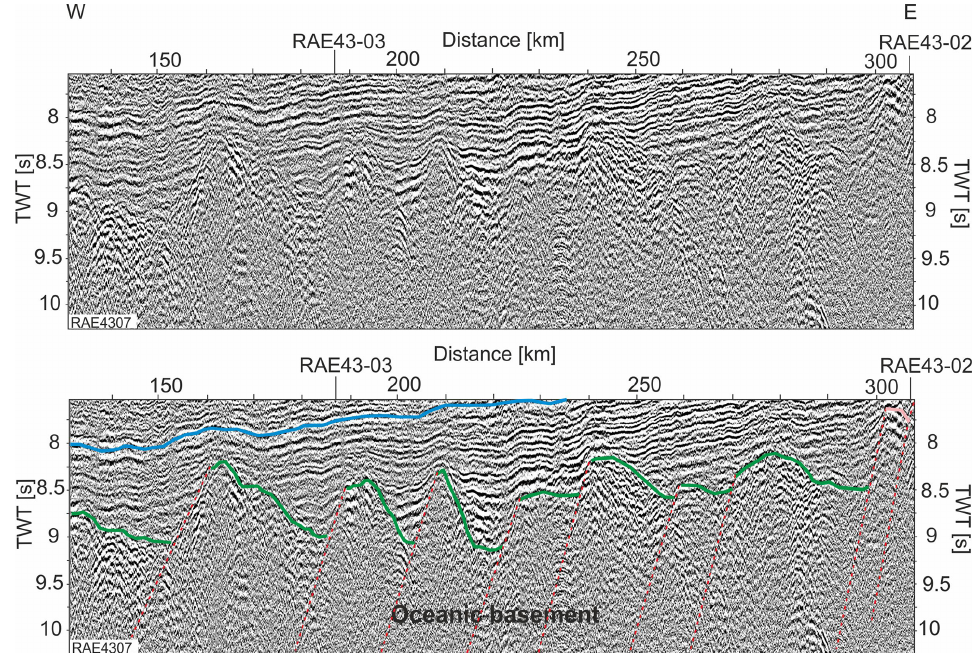
Figure 8. Close-up view of the faulted oceanic basement presented in Fig. 7 in the Riiser-Larsen Sea close to the Gunnerus Ridge. The lower panel shows the interpreted section of the profile.